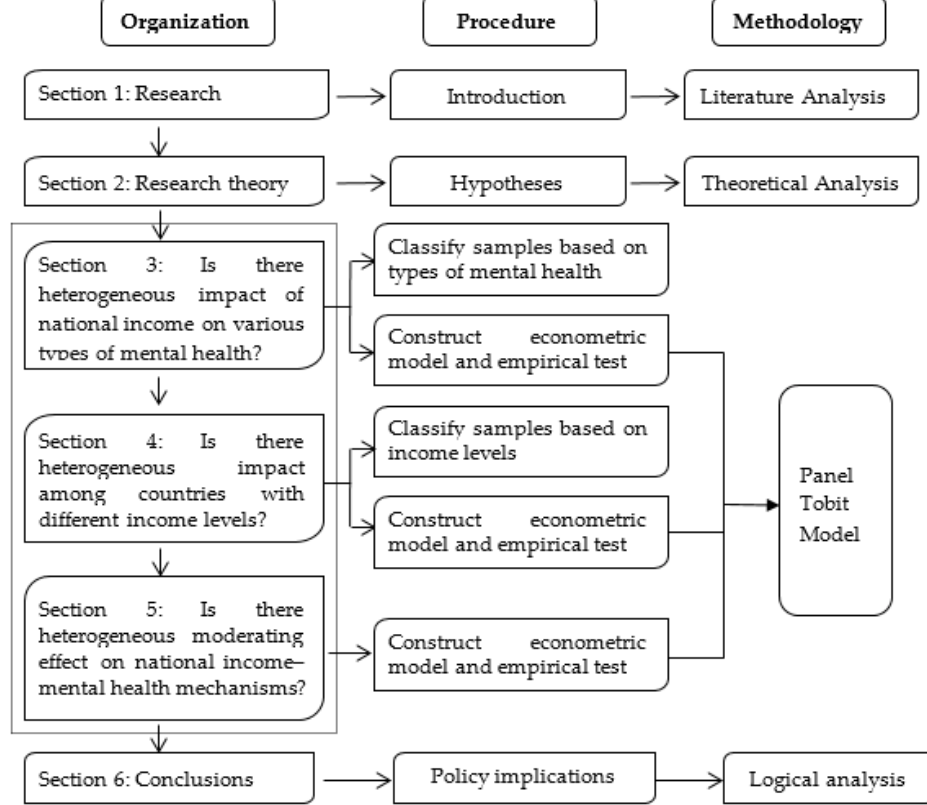
Figure 1. The logical organization of this paper.